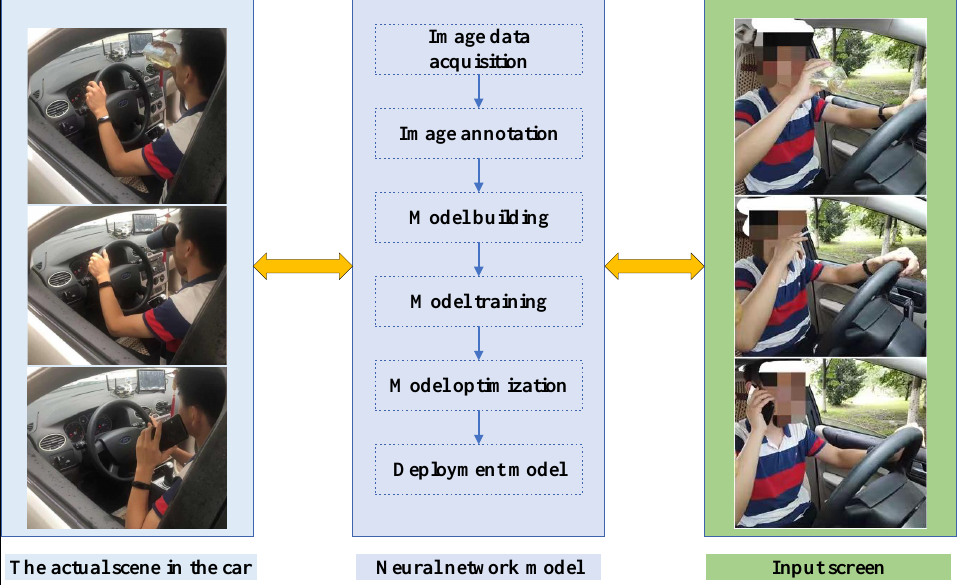
Figure 5. Design block diagram of driver status recognition system.